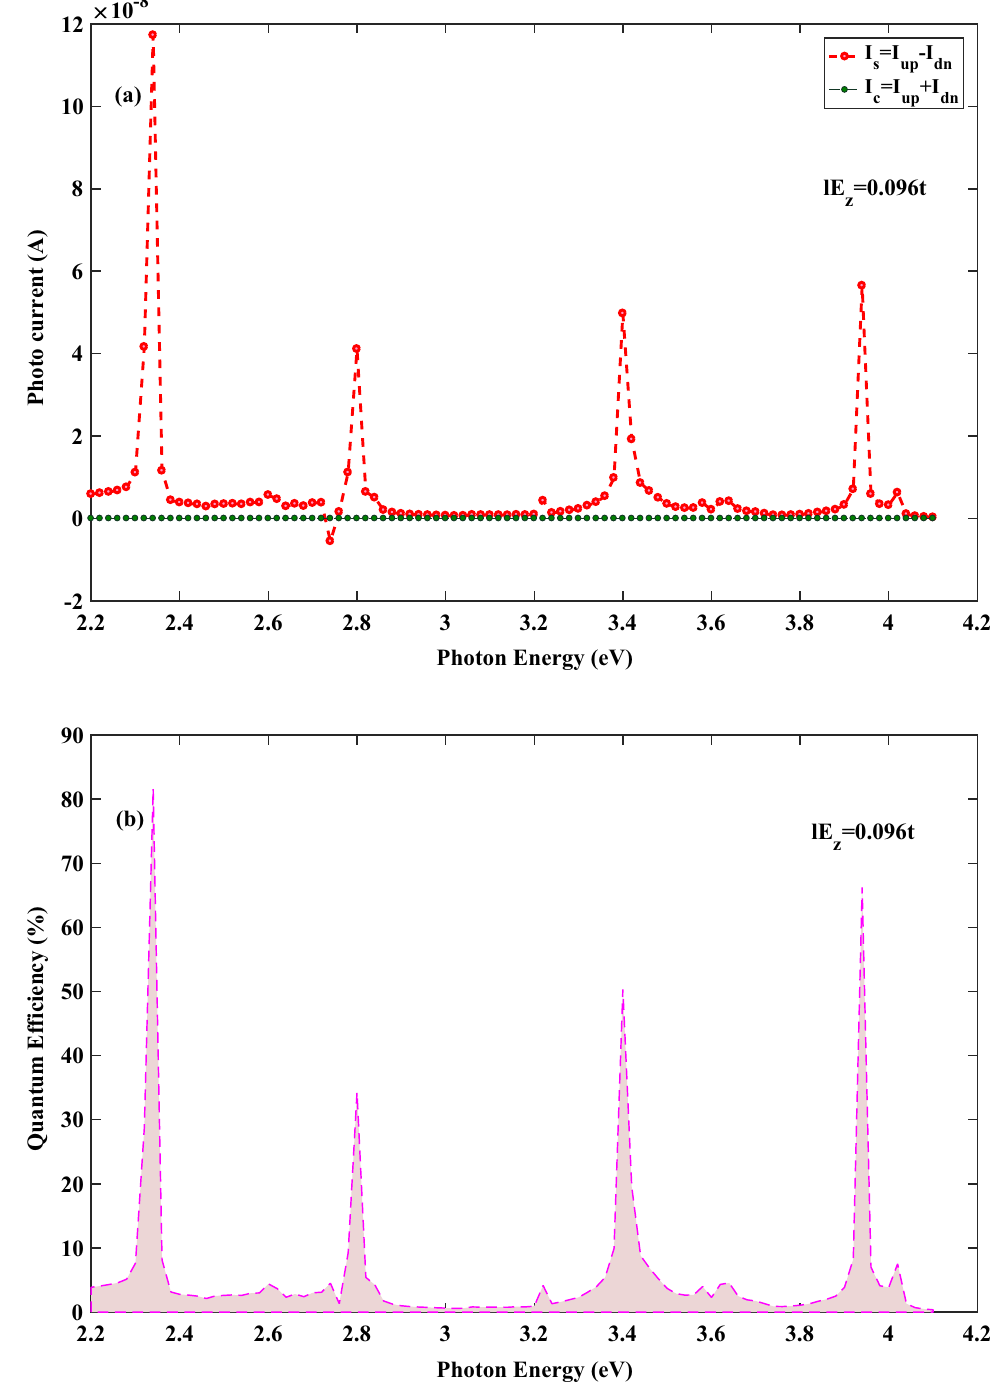
Figure 3. ( a ) Spin and charge photocurrent and ( b ) Quanmtum efficiency as a function of the photon energy for the spin-photovoltaic device based on 8 SZNR under the simultaneous effect of linear illumination with 0.096 t 100 kW elE z I w cm 2 and = =